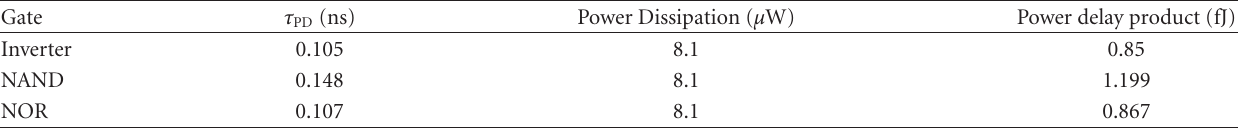
Table 3: PFSCL Tristate gates based on sleep transistor